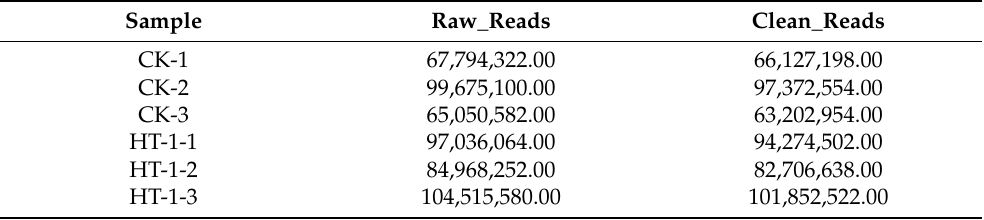
Table 1. Summary of trimming and read mapping results of the sequences obtained from Rheum palmatum roots treated without or with HT-1 strain